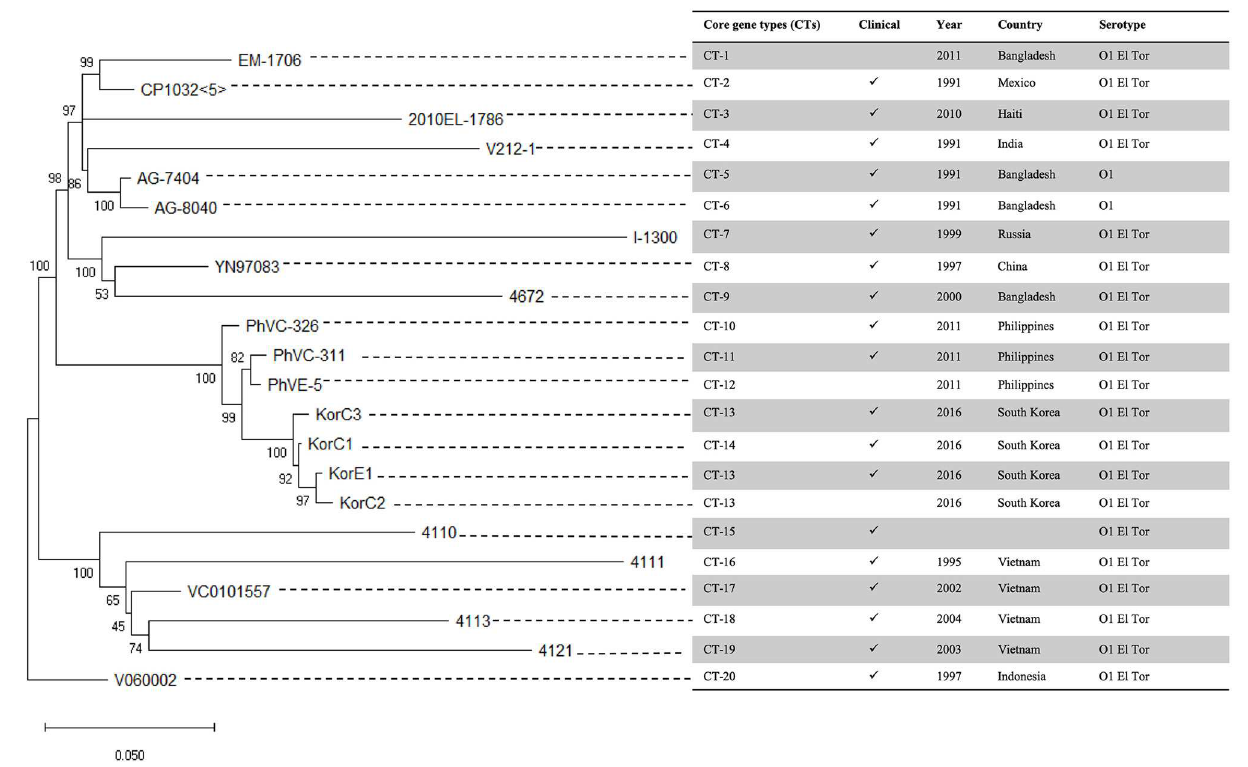
FIGURE 1 | Maximum likelihood phylogenetic tree of Korean isolates and related strains with single nucleotide variant (SNV) data. The tree was generated using RAxML. The scale bar indicates substitution rate per site. Analysis of wgMLST data shows that 3 Korean strains (KorC2, KorC3, and KorE1) shared the same core gene type, and that the KorC1 strain only differs by one hypothetical